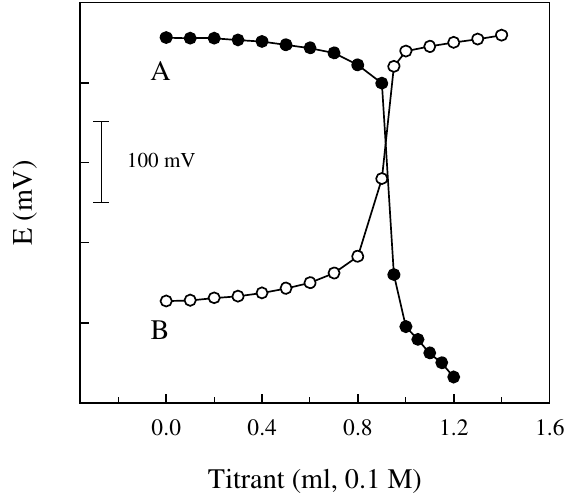
Figure 5. Application of the electrode based on Hg(MBT) 2 for potentiometric titration of (A) 100 mL 1×10 - 3 M Ag + with 0.1 M I - and (B) 100 mL 1×10 - 3 M I - with 0.1 M Ag + . Other conditions are given in Table 2.